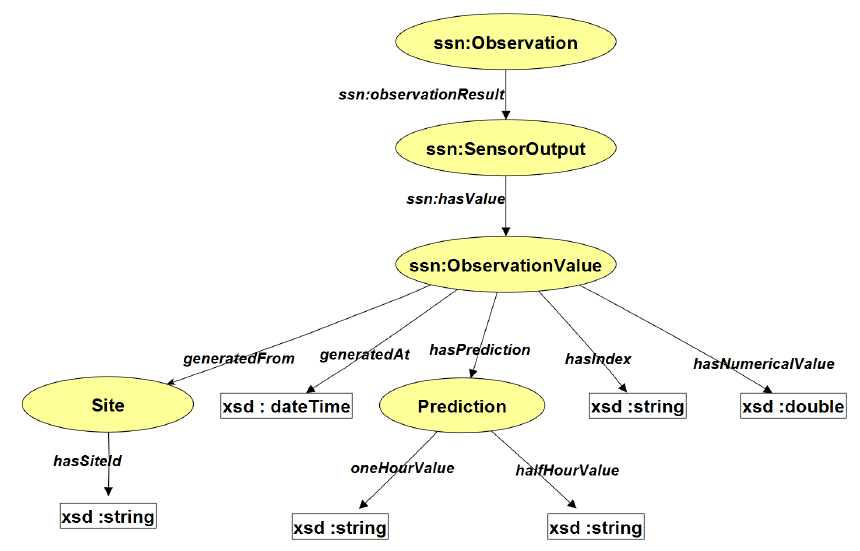
Figure 8. Fragment of the ontology showing the data